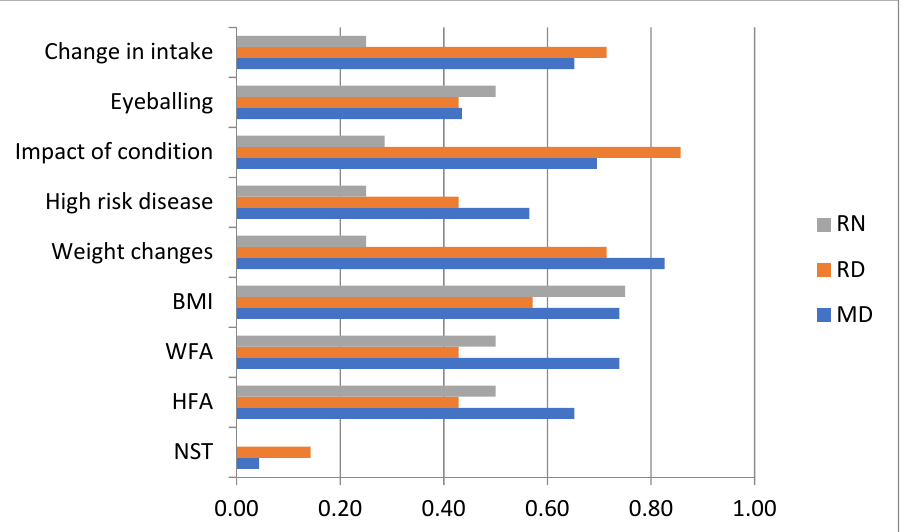
Figure 1. Nutritional screening practices in Canadian tertiary pediatric hospitals by health care profession. RN: registered nurses, RD: registered dietitians, MD: medical doctors, BMI: body